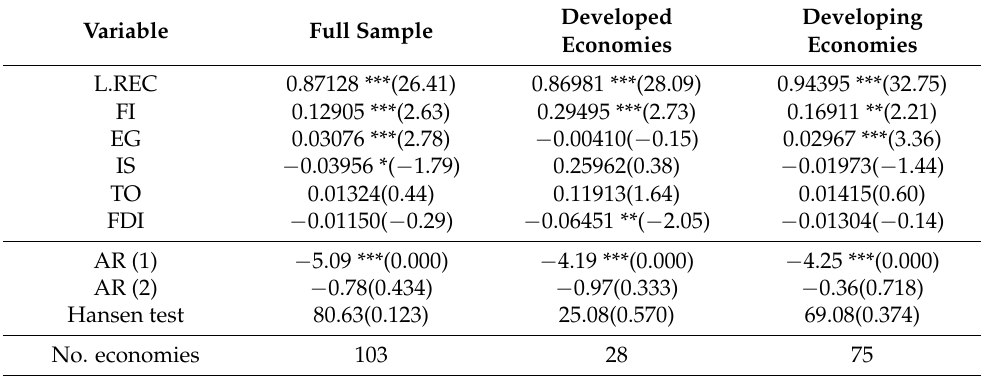
Table 7. Regression results of second level of financial development (FI).